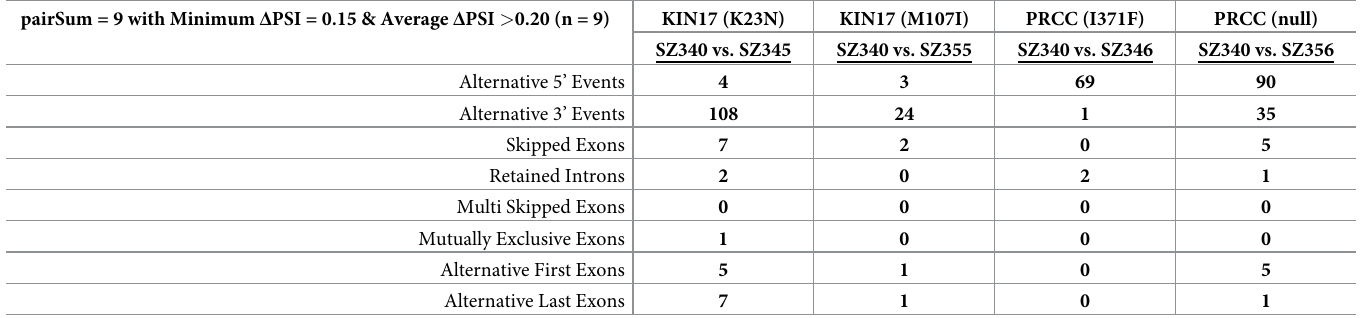
Table 1. Type III Suppressors have Variable Effects on Genome-Wide Alternative Splicing. pairSum = 9 with Minimum Δ PSI = 0.15 & Average Δ PSI > 0.20 (n =